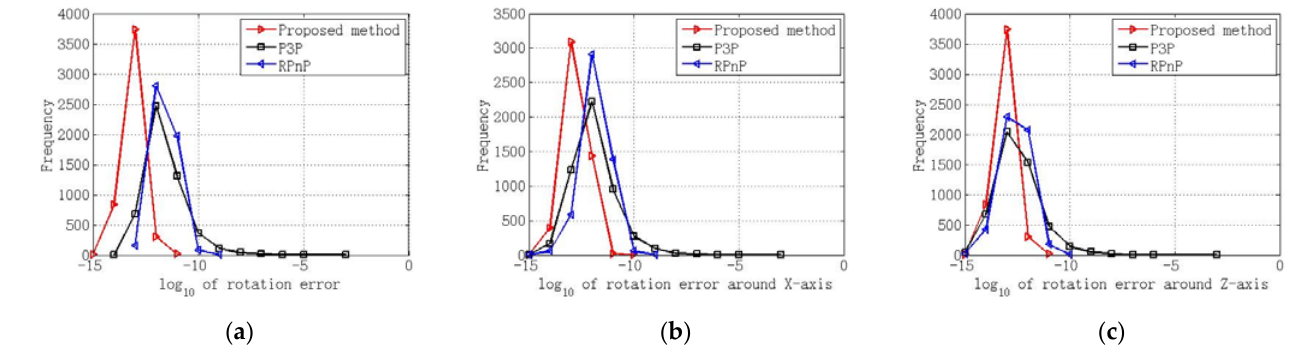
Figure 4. The performance of numerical stability for our proposed method (red), P3P solver (black),